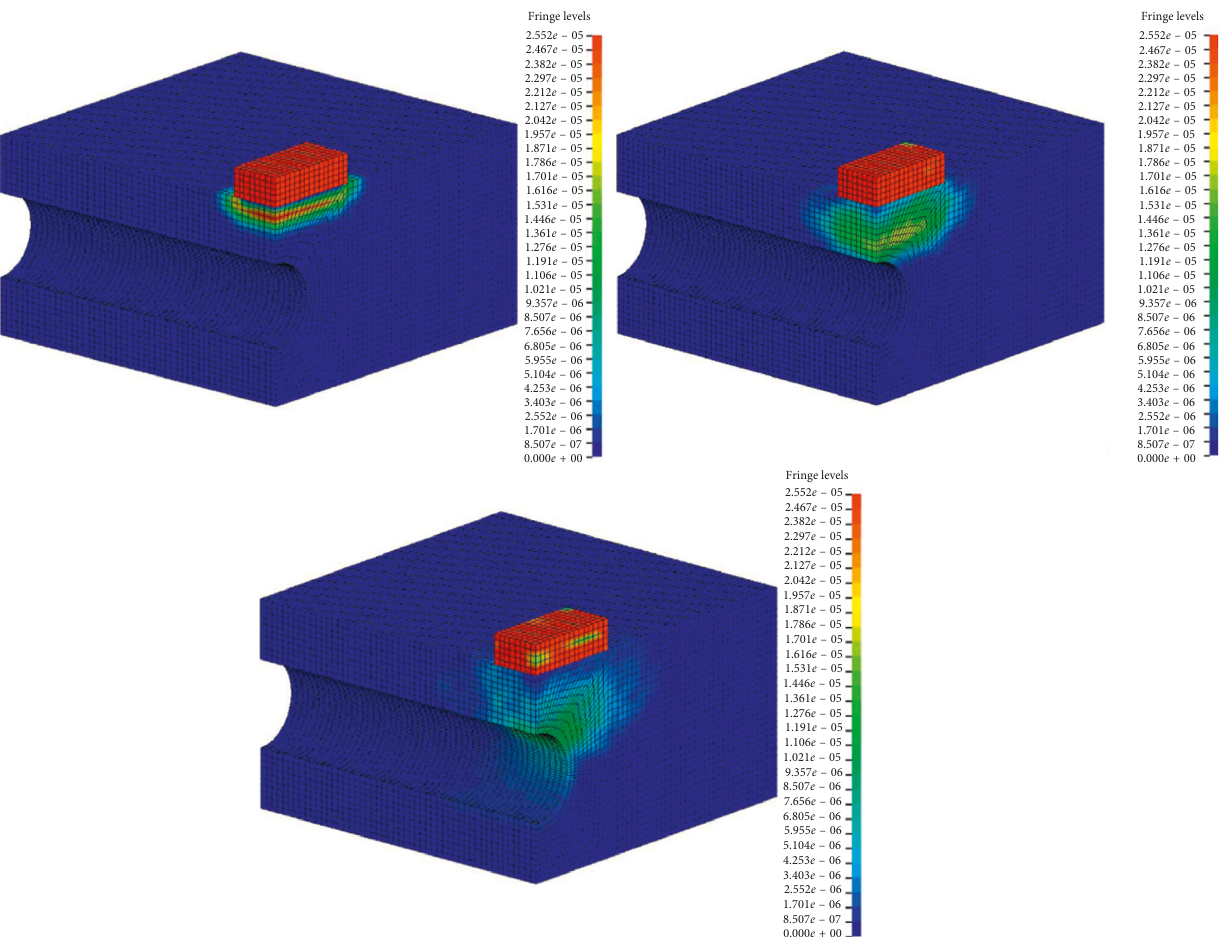
Figure 8: Stress cloud map of the impact process.